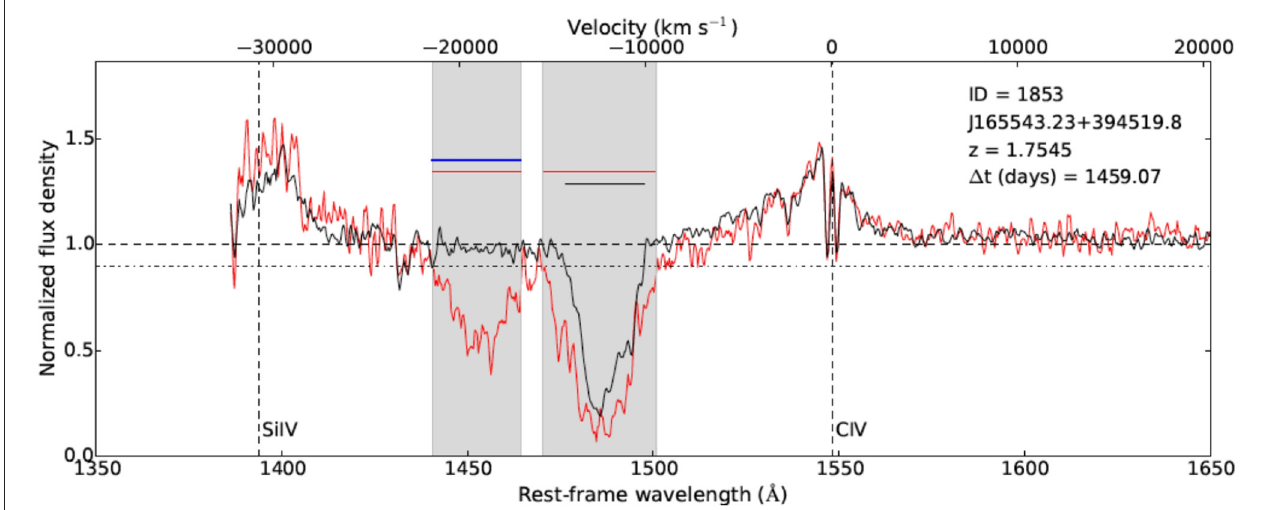
FIGURE 1 | Overplot of a pair of SDSS-I/II (red) and BOSS (black) spectra showing a disappearing BAL trough and an additional non-disappearing BAL trough. We report the source ID in our catalog, the SDSS ID, the redshift, and the rest-frame time difference between the two spectra. Plots are limited to the wavelength window where C IV BAL disappearance can be observed. Horizontal axes: rest-frame wavelength (bottom) and velocity (top); vertical axis: normalized flux. Horizontal dashed line: normalized flux density = 1; dash-dot line: normalized flux density = 0.9. Vertical dashed lines: Si IV (1,394 Å) and C IV (1,549 Å) emission lines (rest-frame wavelengths). Red/black horizontal lines: BAL troughs in the SDSS-I/II/BOSS spectra; blue bars: SDSS-I/II BAL troughs that disappear in BOSS spectra. The regions corresponding to SDSS-I/II BAL troughs are shaded for better visualization.